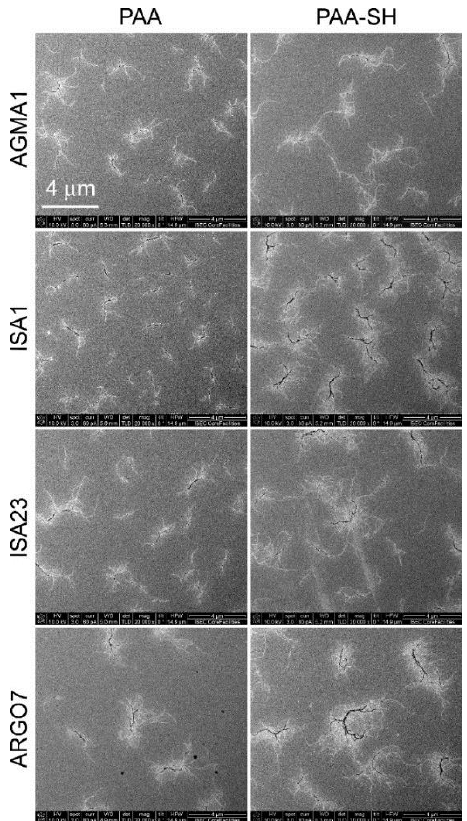
Figure 2. SEM analysis of PAAs, before (PAA) and after the introduction of sulfhydryl groups (PAA-SH).